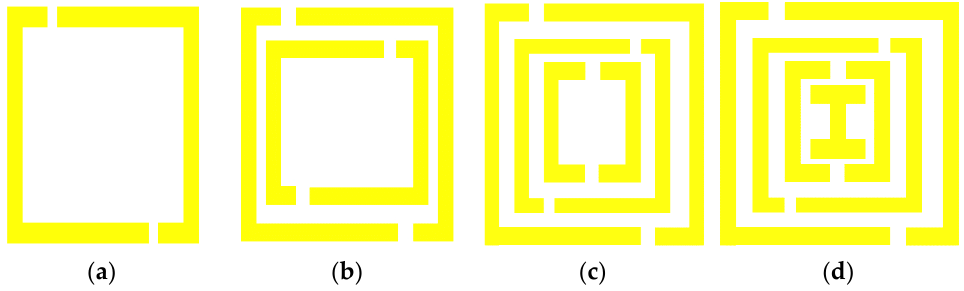
Figure 3. Design steps for the proposed ISMeTM unit cell: ( a ) design step-a; ( b ) design step-b; ( c ) design step-c; ( d ) design step-d (ISMeTM). Table 2. Parameters of various design